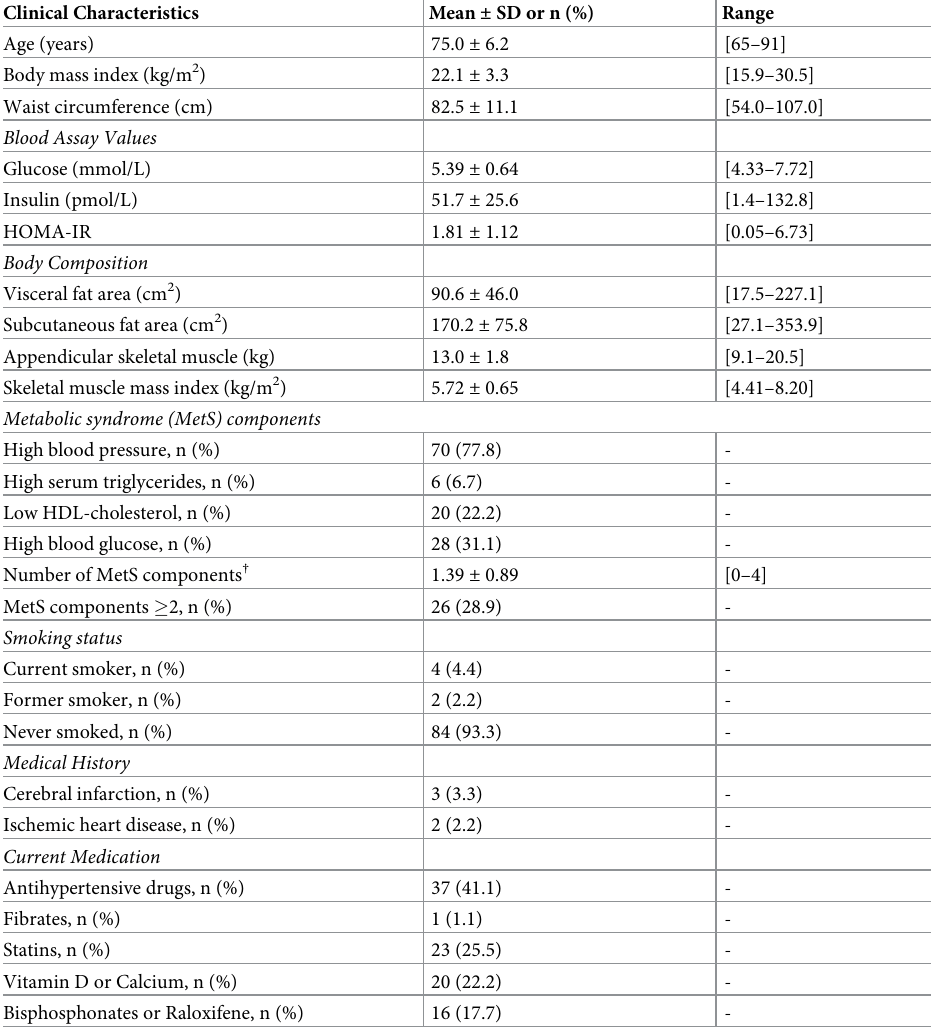
Table 1. Descriptive statistics for the clinical characteristics of the patient sample (n =